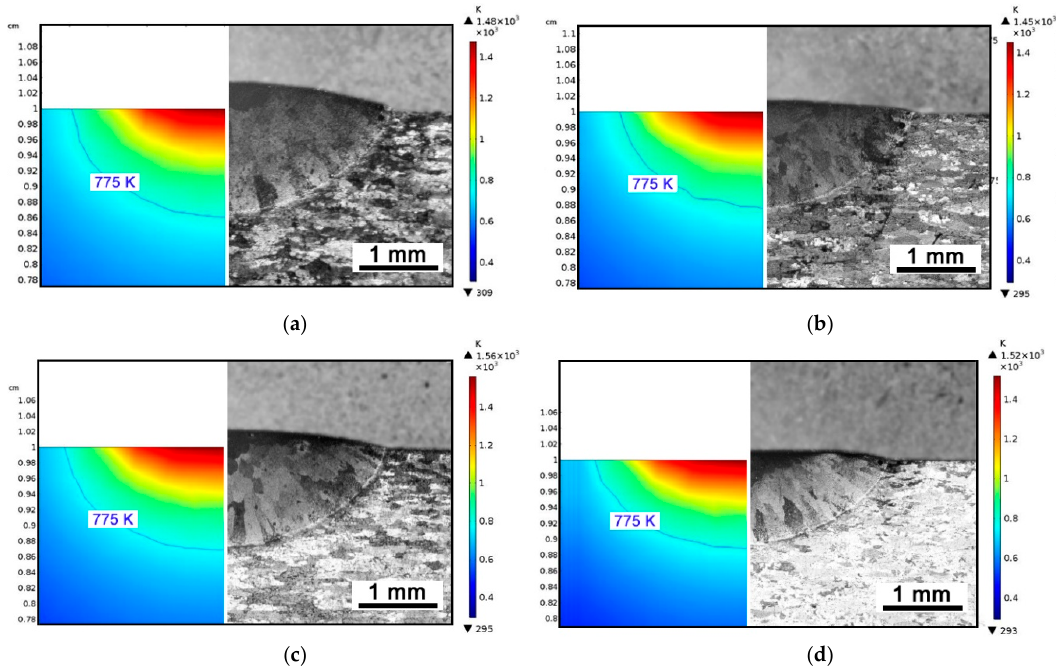
Figure 20. Comparison between simulated size (left side of each image) and actual size (right side of each image) of the fusion zone for given feeding rate of 3 g ∙ min − 1 . Contour lines are drawn one time-step fraction before metal addition. ( a ) Power 2.5 kW; travelling speed 450 mm ∙ min − 1 ; ( b ) Power 2.5 kW; travelling speed 900 mm ∙ min − 1 ; ( c ) Power 3.0 kW; travelling speed 900 mm ∙ min − 1 ; ( d ) Power 3.0 kW; travelling speed 1800 mm ∙ min − 1 . Table 8. Actual vs. predicted size of the fusion zone in single track, for given feeding rate of 3 g ∙ min − 1 .